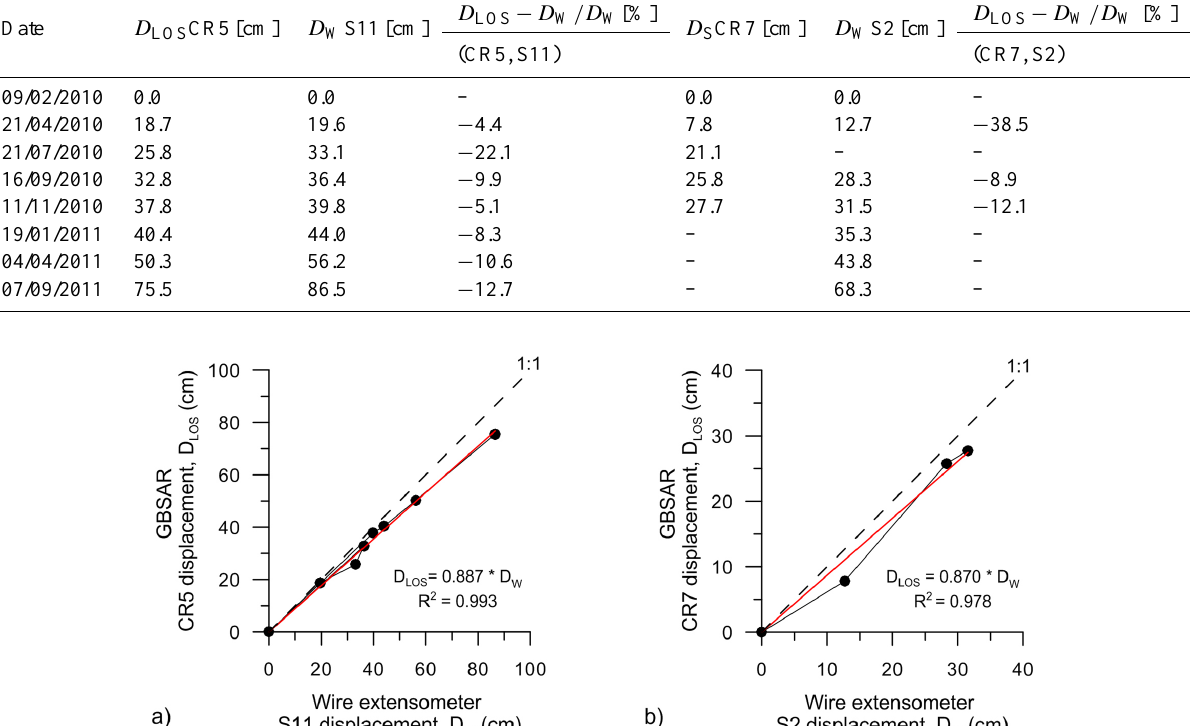
Fig. 8. Charts showing GB-SAR displacement against wire extensometer displacement: (a) for CR5 and S11, between February 2010 and September 2011, and (b) for CR7 and S2, between February 2010 and November 2010. The charts are created using the data included in Table 2. Red lines show the optimum linear fit to the data. Dashed lines show straight lines with a slope of 1:1. The comparison of GB-SAR displacements and total dis- placements measured by extensometer ( D W ) was done at three levels involving an increasing transformation of the data to account for systematic differences in